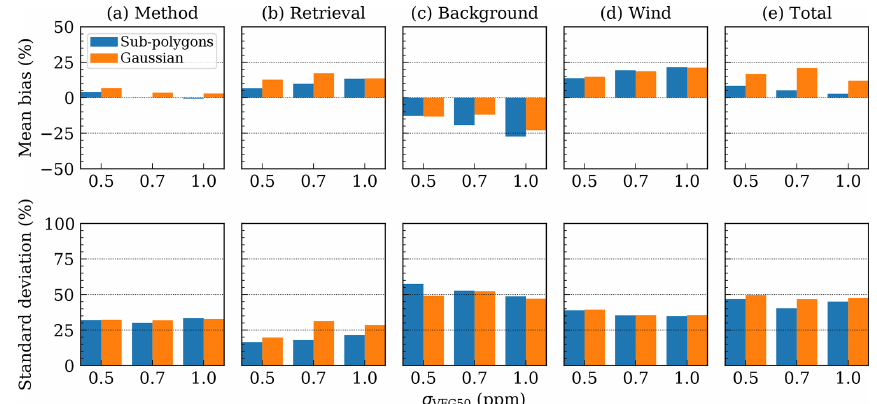
Figure 8. Mean bias (MB) and standard deviation (SD) of (a) method, (b) retrieval, (c) background, (d) wind and (e) total errors for CO 2 - based plume detection. MB and SD are shown for the three uncertainty scenarios and for line densities computed from sub-polygon means and Gaussian function, respectively.